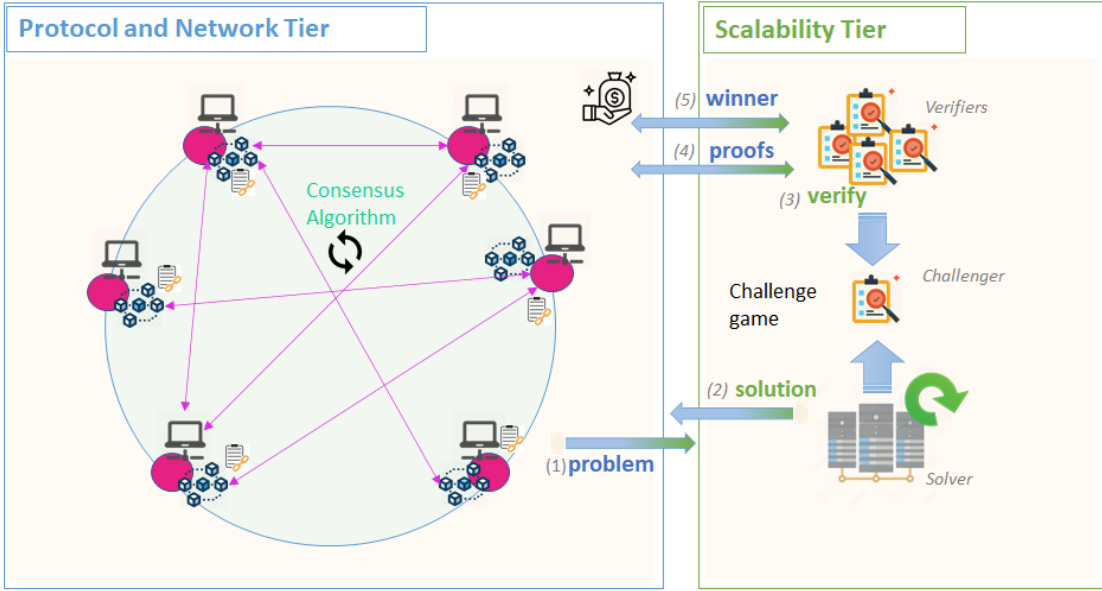
Figure 7. Scalability Tier—Proof of Computation mechanism.